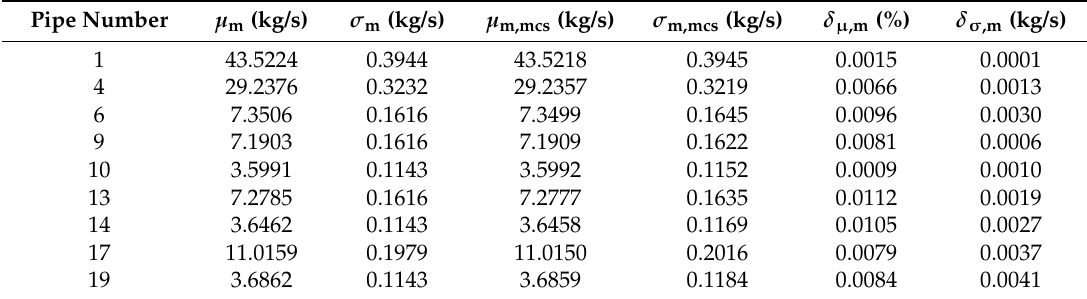
Table 3. Typical mean and standard deviations of mass flow rates. (Test 1: L = 1000 m; µ ϕ = 0.5 MW; σ ϕ = ± 10%).